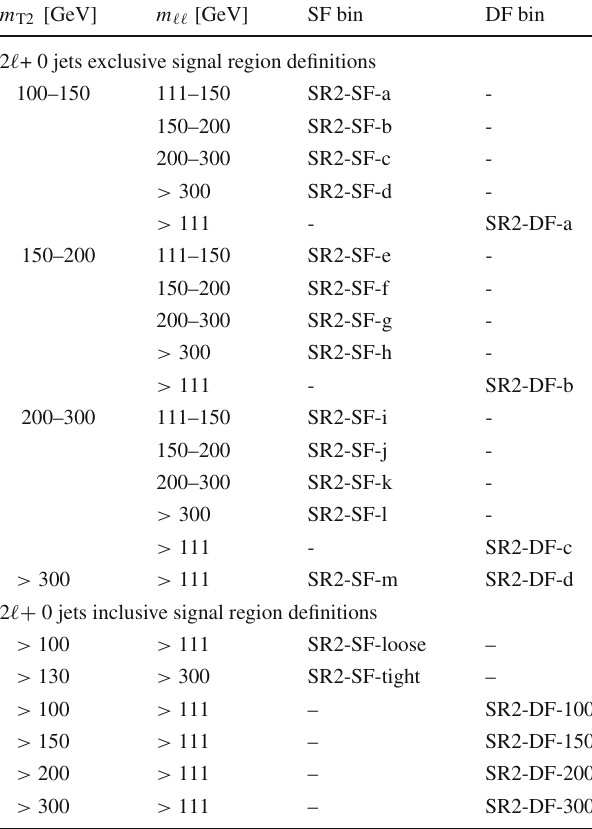
Table 1 The definitions of the exclusive and inclusive signal regions for the 2 (cid:4) + 0 jets channel. Relevant kinematic variables are defined in the text. The bins labelled “DF”or “SF” refer to signal regions with different-flavour or same-flavour lepton pair combinations,